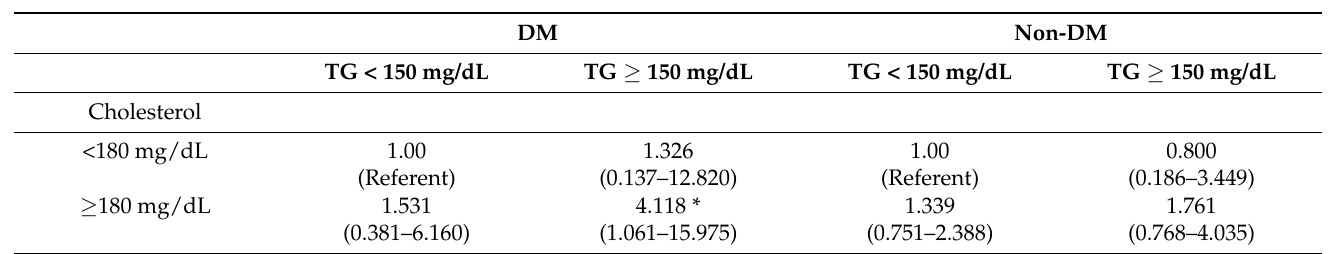
Table 3. Combination effects for cholesterol, triglyceride (TG) level, and colorectal cancer risk in DM and non-DM